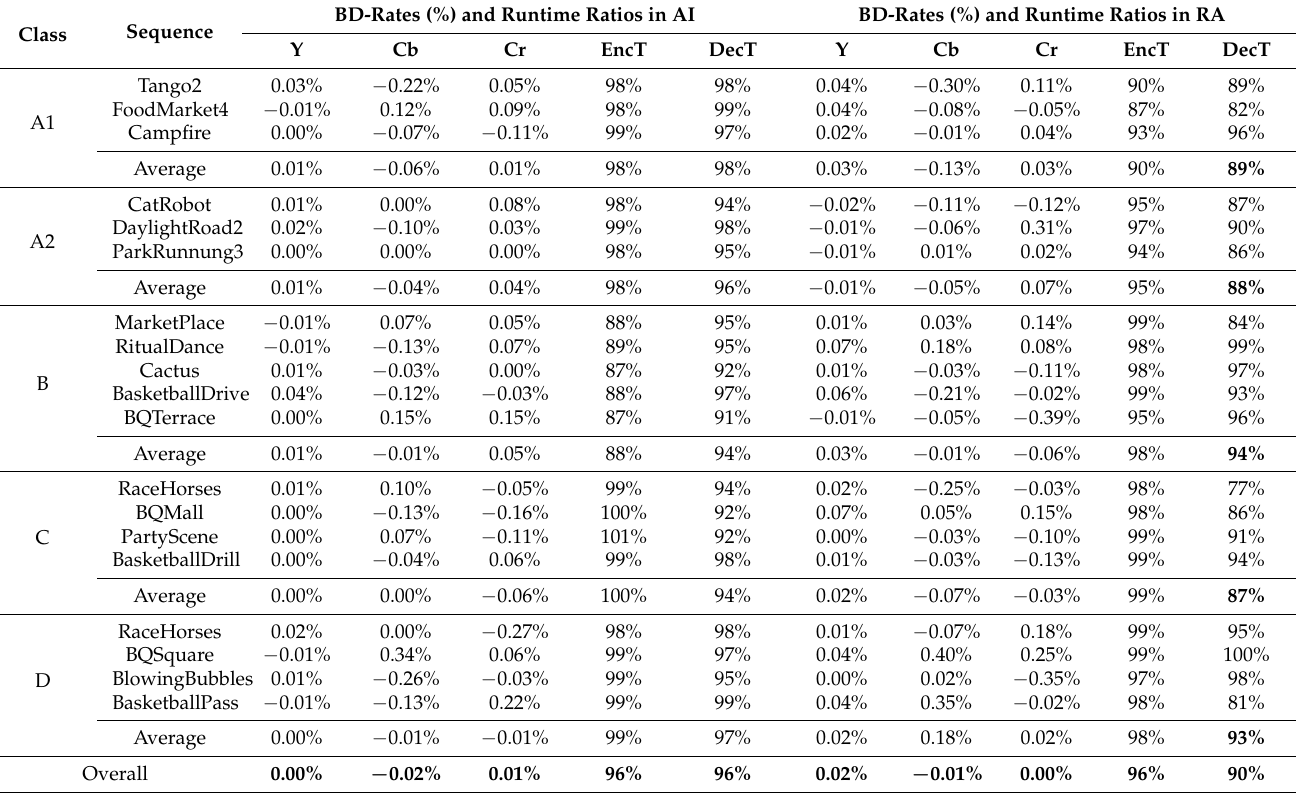
Table 10. Experimental results of VVC inverse transform vs. the proposed method for class (A to D)